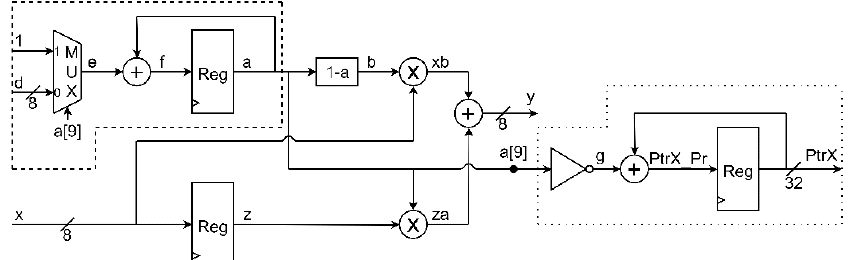
Figure 7. Circuital implementation of the proposed algorithm.